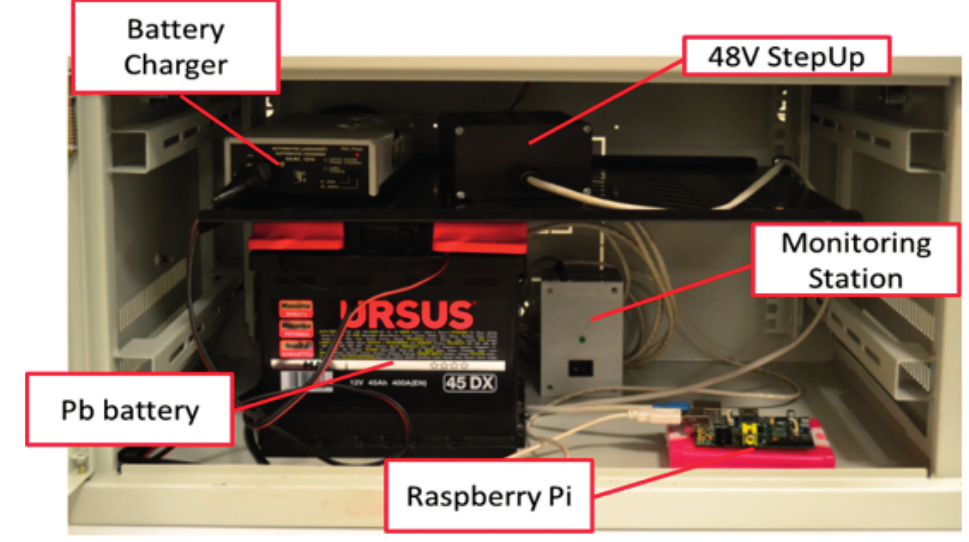
Figure 5. The system placed in a shelter for laboratory tests.